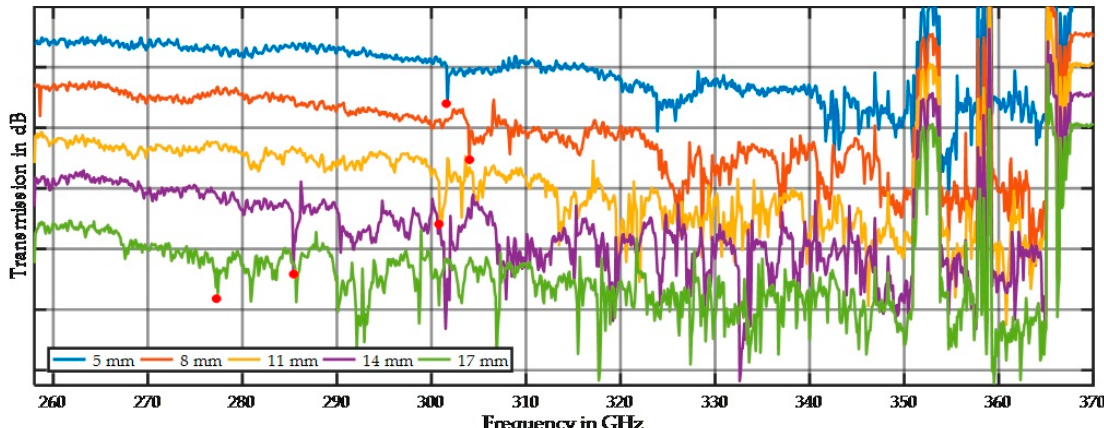
Figure 14. Spectral behavior of five different sample thicknesses for the fraction from 400 µm to 500 µm. The red dots indicate the first spike in each spectrum. For better visibility, an offset of − 10 dB was applied between each spectrum.